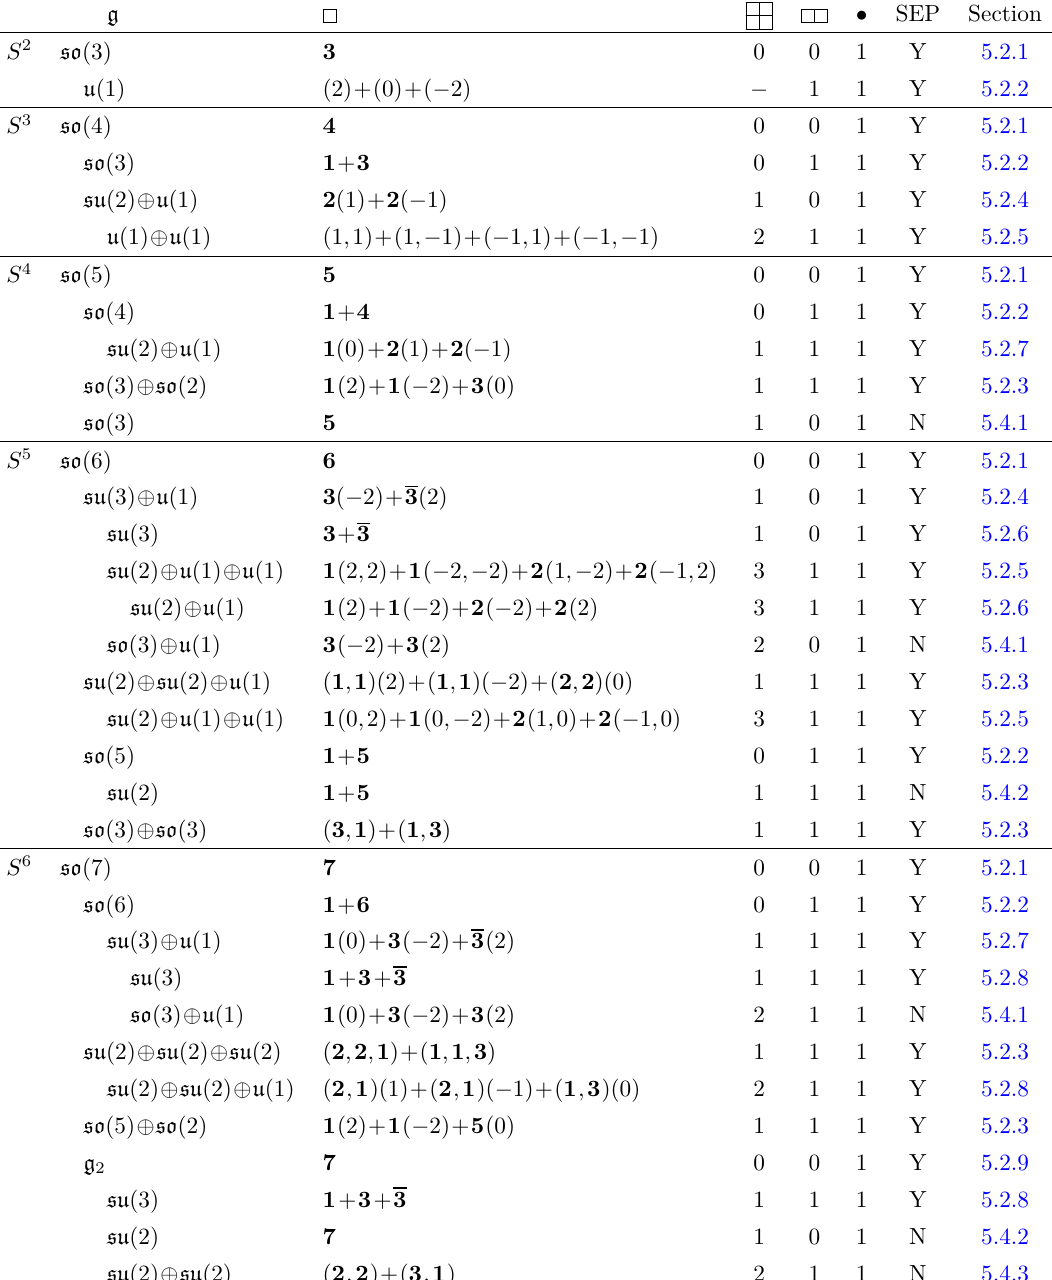
Table 1 . Separating isometries on n -spheres, S n , n = 2 , . . . , 6